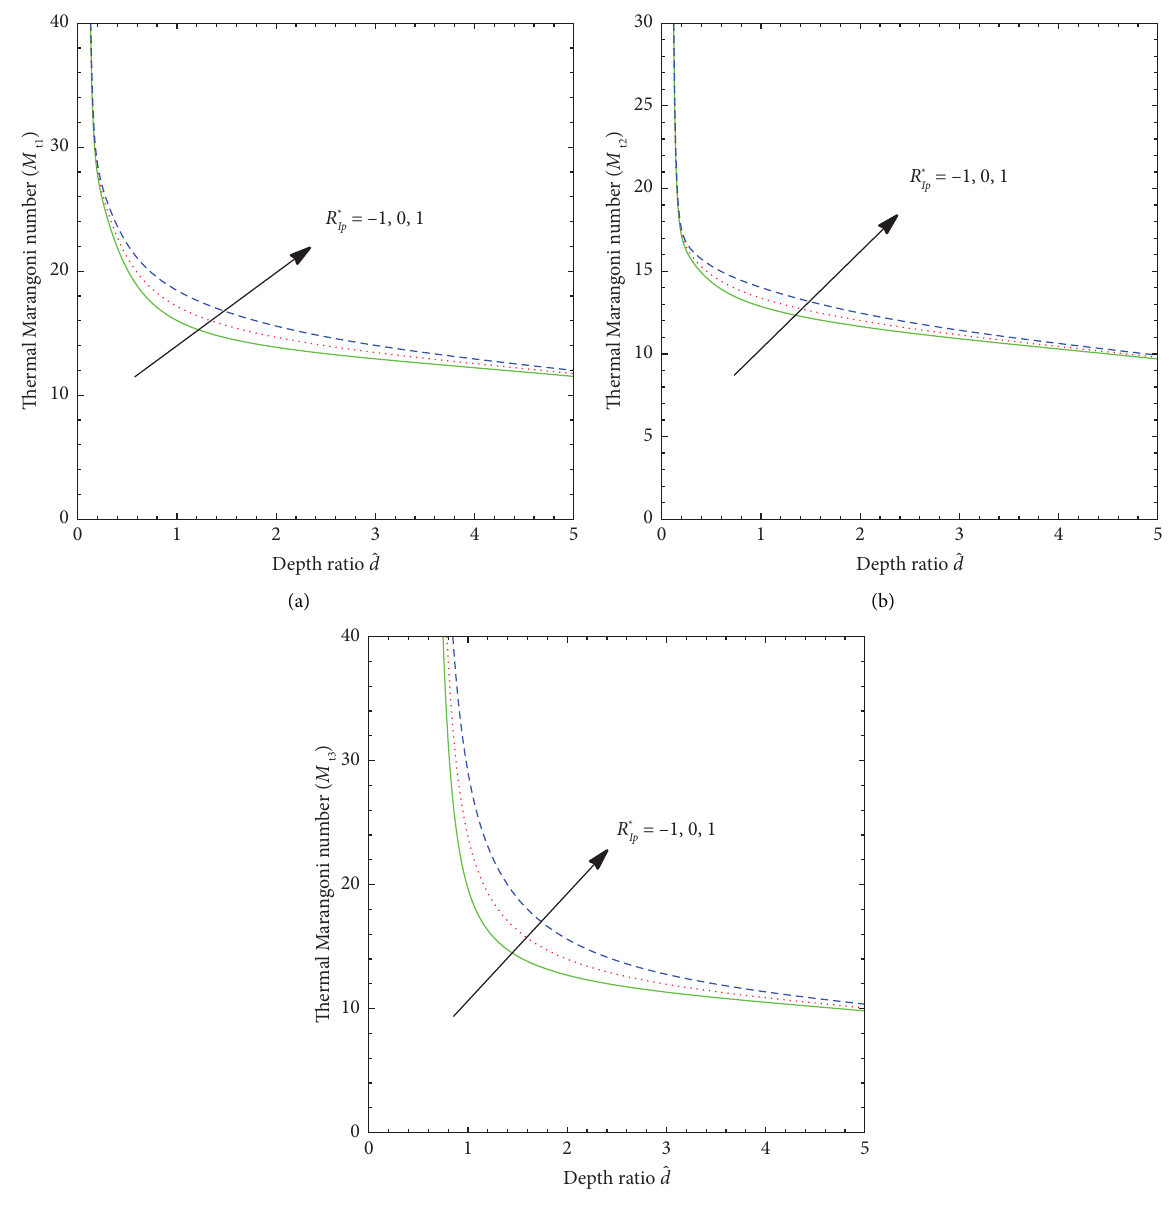
Figure 4: Modifed Rayleigh number R ∗ R ∗ � 1, M � S If